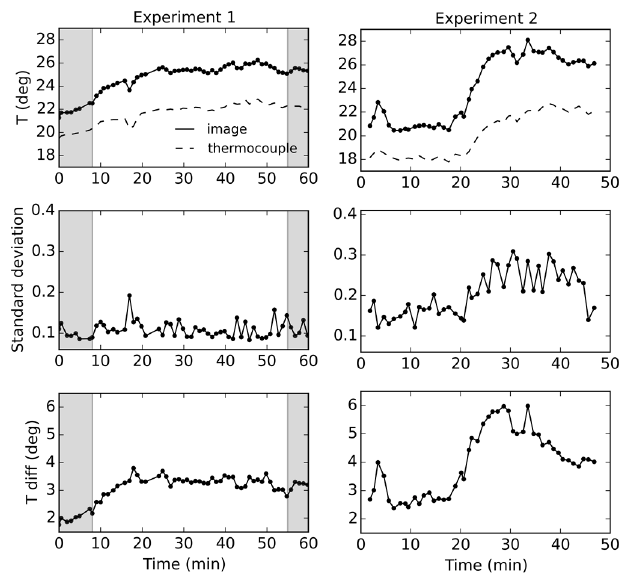
Figure 6. Retrieved image and thermocouple temperature measurement of the calibration target with corresponding differences between the two and image standard deviations. Shaded areas indicate times at which the additional light sources were turned off.